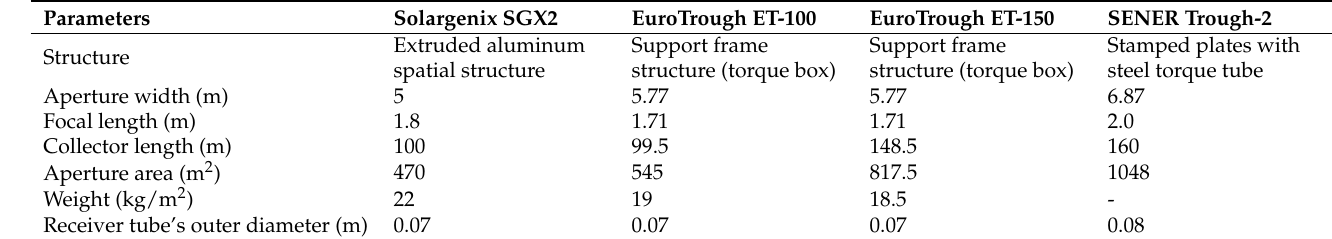
Table 1. General characteristics of the parabolic-trough collectors (PTCs) [18–20].